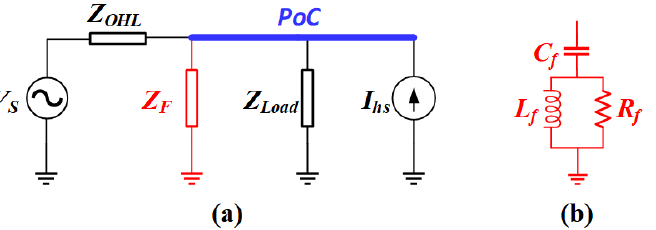
Figure 1. ( a) Equivalent circuit modeled for problem formulation, ( b ) 2nd-order high-pass PPF.